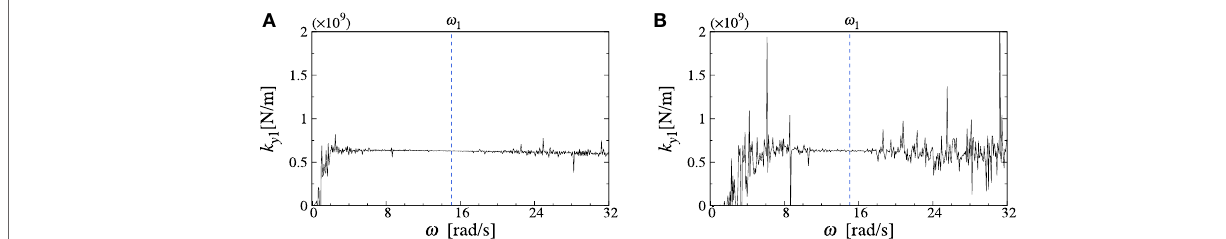
FIGURE 6 | Identification result of lateral stiffness (model B), (A) noise level 0%, (B) noise level 5%.